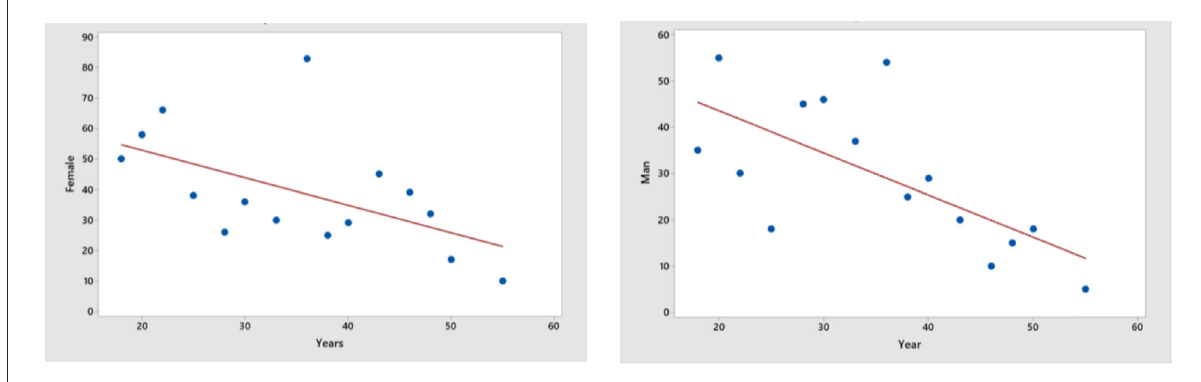
FIGURE3 Distribution of respondents by age and gender. Source: Researchers’ elaboration based on research